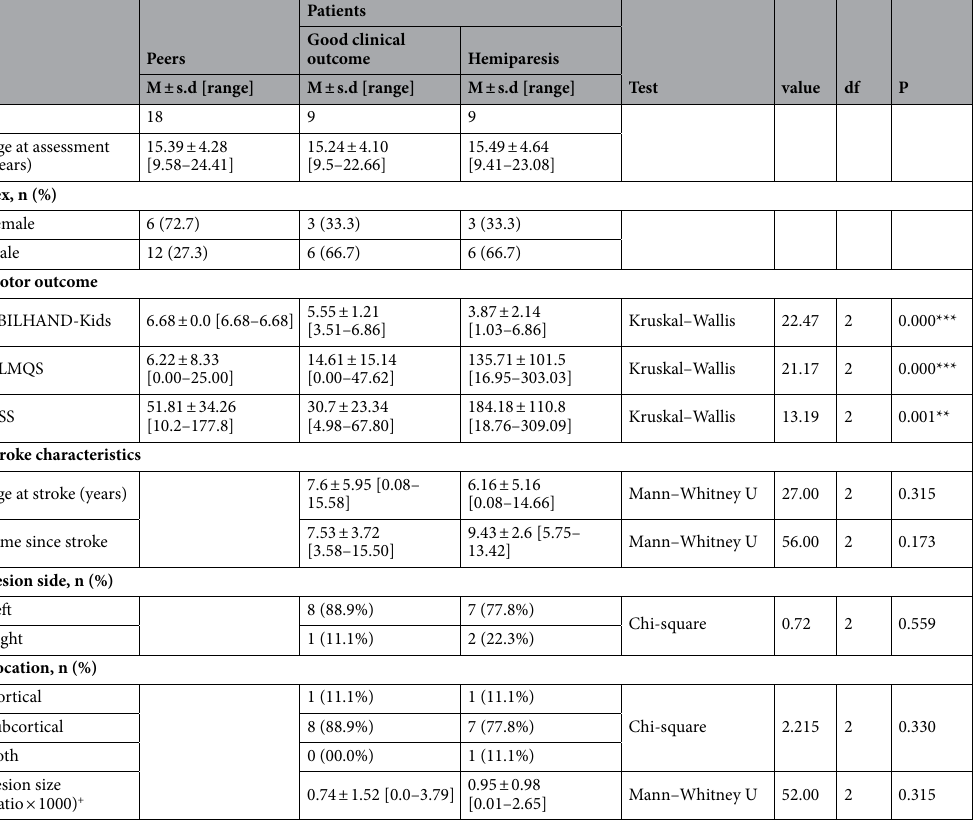
Table 1. Participants’ characteristics and clinical outcome. peers typically developing peers, HSS total hand strength score, ULMQS Upper Limb Movement Quality Score. Lesion size = lesion size/total intracranial volume. Significant at: *P < 0.05; **P < 0.01; *** P <